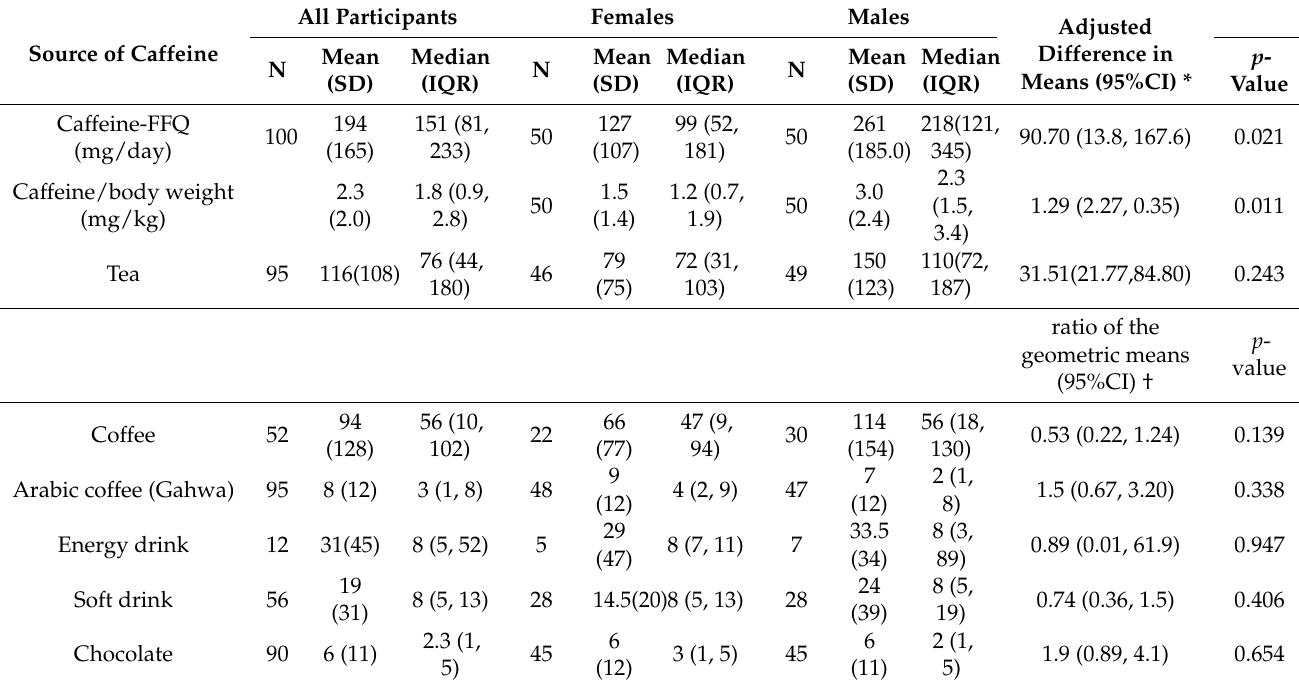
Table 2. Mean (SD) and median (IQR) of total caffeine intake (mg/day) by source and gender, and the tested mean differences between